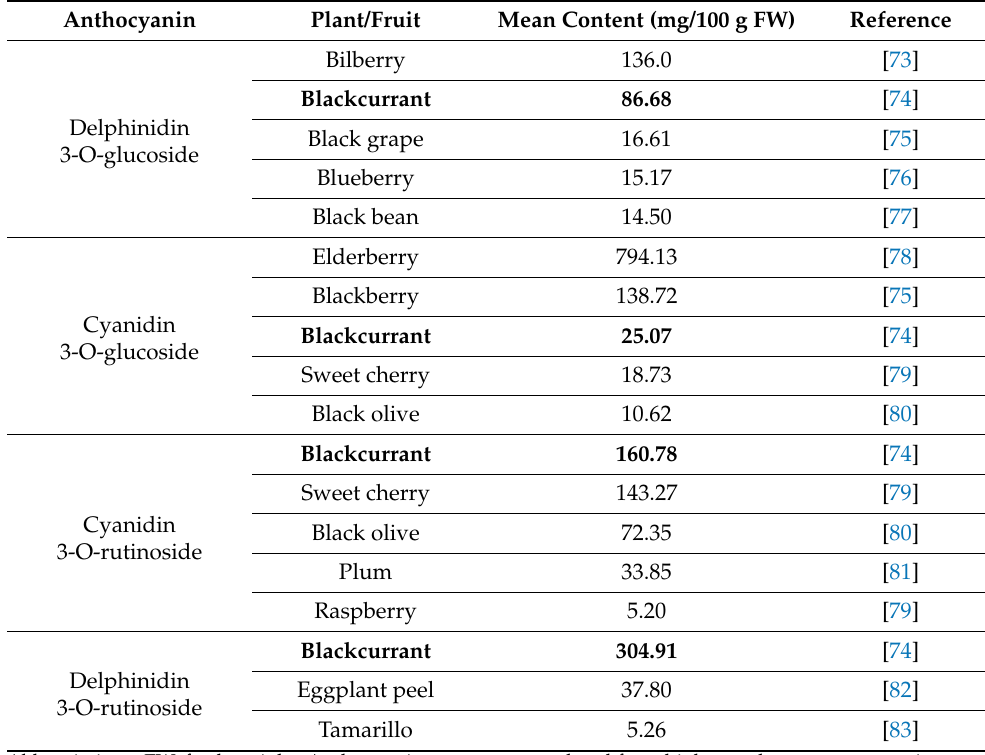
Table 2. Content of edible berries/plants for the anthocyanins delphinidin 3-O-glucoside,